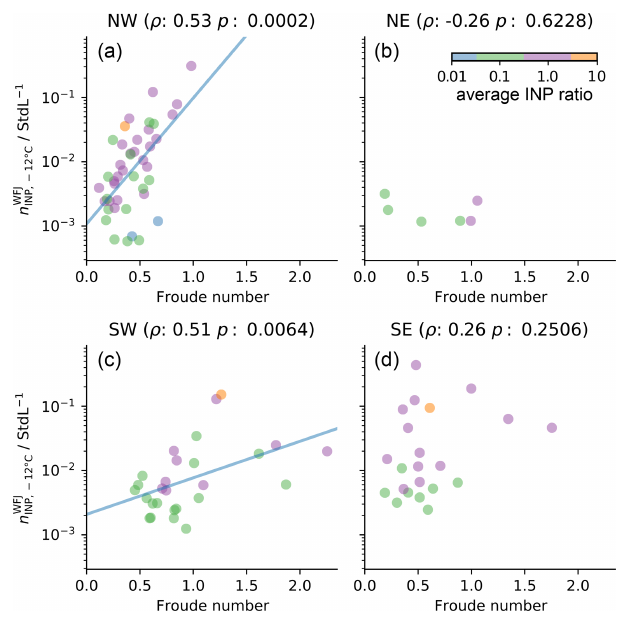
) as a Figure 7. INP concentration at − 12 ◦ C at WFJ ( n WFJ INP ;− 12 ◦ C function of the Froude number (see Eq. 4) for the four mesoscale wind direction sectors (as indicated in Fig. 1). For each subplot, the Figure 8. Average INP ratio ( r INP ; as defined in Eq. 5) between Spearman’s rank coefficient ( ρ ) and the corresponding two-sided synchronous INP samples taken at WFJ and WOP as a function of p value ( p ) are shown at the top. The colors of the dots indicate the altitudinal θ e gradient for each wind direction sector. The dashed average INP ratio between WFJ and WOP (to assess the similarity (horizontal) line indicates an average INP ratio of 1. The dotted of the INP concentration of both sites), as defined in Eq. (5). Lines (vertical) line indicates θ e gradient of 0, representing a neutrally are exponential fits in the case of | ρ | ≥ 0.5. layered lower atmosphere. For each sector, the Spearman’s rank co- efficient ( ρ ) and the corresponding two-sided p value ( p ) are shown at the top. The marker shape indicates the sampling time (morn- ing, afternoon, and night; according to the time periods defined in Fig. 4). The color of the markers indicates the INP concentration at − 12 ◦ C measured at WFJ. Blue solid lines are exponential fits in case | ρ | ≥